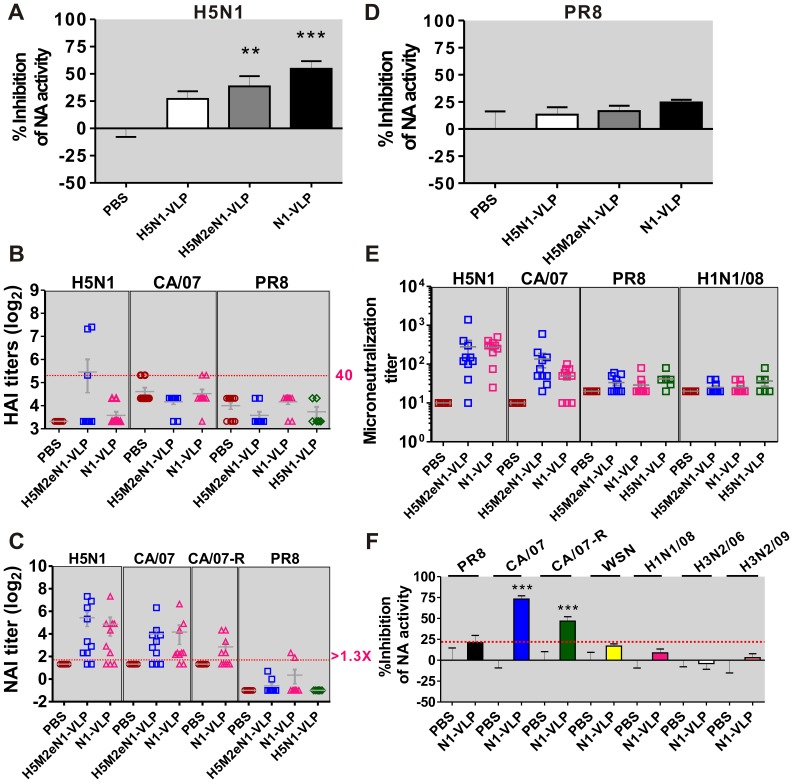
N1-based VLPs induced cross-reactive humoral immune responses.(A) VLP-induced avN1 antibodies against the NA activity of the homologous H5N1 virus. Sera were collected from mice immunized with 15 µg dosages and types of VLPs as labeled and diluted tenfold for NA inhibition assay. (B) HAI titers and (C) NAI titers induced by N1-based VLPs against homologous and heterologous viruses were determined. The viruses are indicated above. (D) Antisera elicited by different VLPs were fivefold diluted and examined for the inhibition of NA activity derived from PR8 virus. (E) Microneutralization assay to assess the humoral immune responses induced by the VLP vaccines against viruses as labeled. (F) Effect of antisera (tenfold dilution) from N1-VLP vaccinated mice on the NA activity of heterologous strains of influenza virus. The NA antigen derived from N1- or N2-serotyped influenza viruses are labeled at top. CA/07-R is a clinical virus strain with a Tamiflu-resistant phenotype. A/Taiwan/9042/2008(H1N1) (H1N1/08), A/Taiwan/83/2006(H3N2) (H3N2/06), and A/Taiwan/4055/2009(H3N2) (H3N2/09) are clinical virus strains isolated from patients in Taiwan. Comparing the vaccination and PBS control groups, asterisk indicates statistic significance as used in Figure 1.